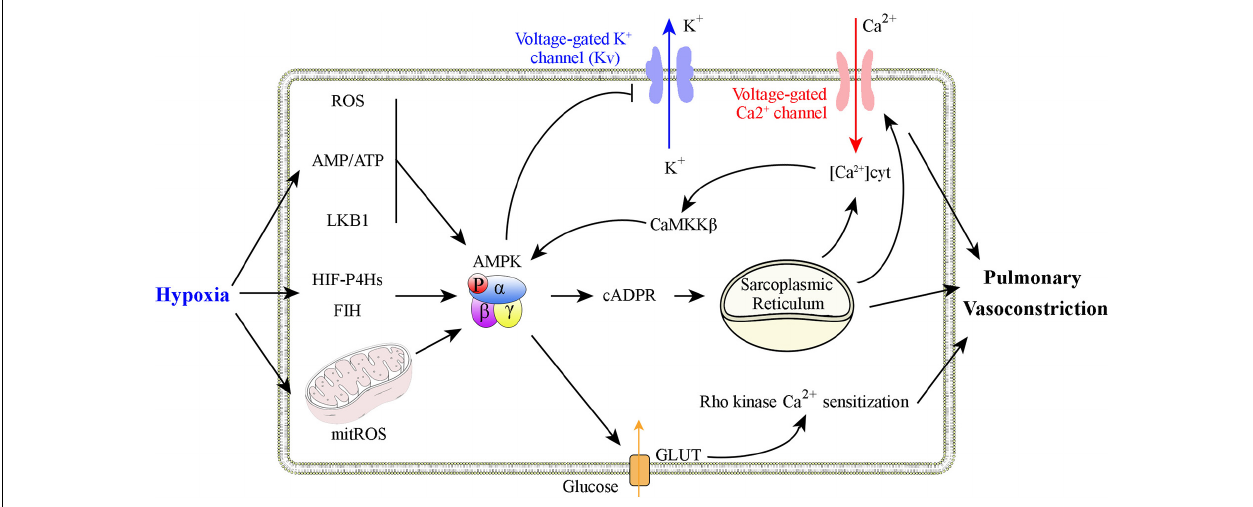
FIGURE 2 | Graphical summary of possible mechanisms that explain how AMPK activation is involved in hypoxic pulmonary vasoconstriction. Physiological hypoxia results in increases in the AMP/ATP ratio, ROS production, and in LKB1 activation to promote AMPK Thr 172 phosphorylation. AMPK activation increases Ca 2 + levels in pulmonary VSMCs to promote constriction through, (1) inhibition of voltage-dependent K + channels, (2) activation of voltage-operated Ca 2 + channels, and (3) activation of Ca 2 + -sensing sarcoplasmic